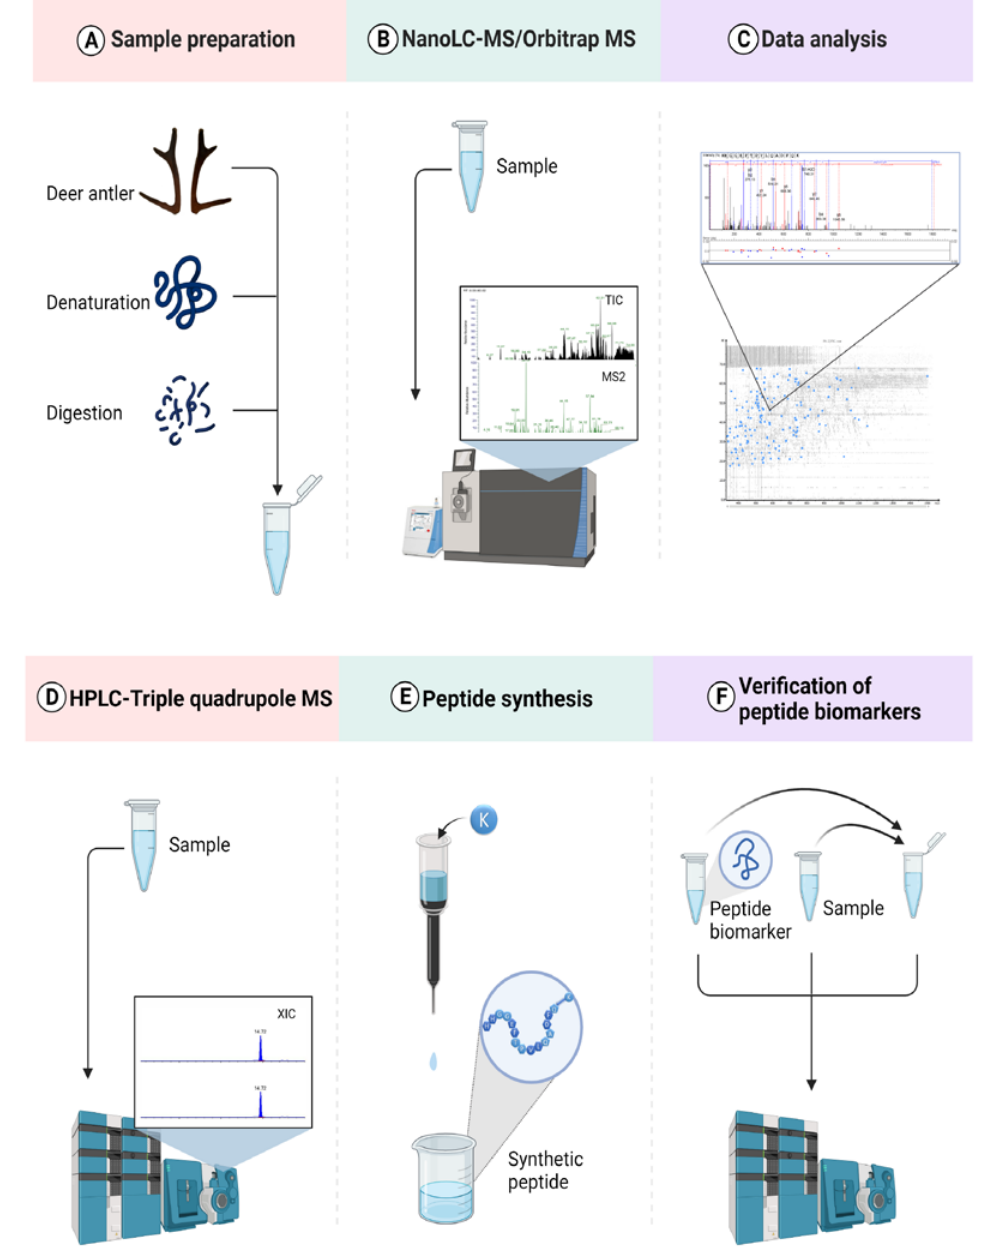
Figure 1. Analytical scheme for identifying peptide biomarkers in deer antlers. (Adapted from “Snapshot Metabolomics”, by BioRender.com (2022). Retrieved from https://app.biorender.com/biorender-templates (accessed on 25 May 2022)). ( A ) Deer antlers were denatured by guanidine hydrochloride and enzymatic hydrolysis by trypsin. ( B ) Analysis of relative deer antler enzymatic hydrolysate was conducted by Nano LC-Orbitrap MS. ( C ) Mass spectrometry data were used in the PEAKS software for analysis, followed by de novo sequencing of peptides, alignment in the database, and generation of peptides biomarkers. ( D ) HPLC-Triple Quadrupole MS analyzed seven species of deer antler enzymatic products in MRM mode. ( E ) Purified peptide biomarkers were obtained by chemical synthesis. ( F ) HPLC-Triple Quadrupole MS was used to confirm the sequence of peptide biomarkers.